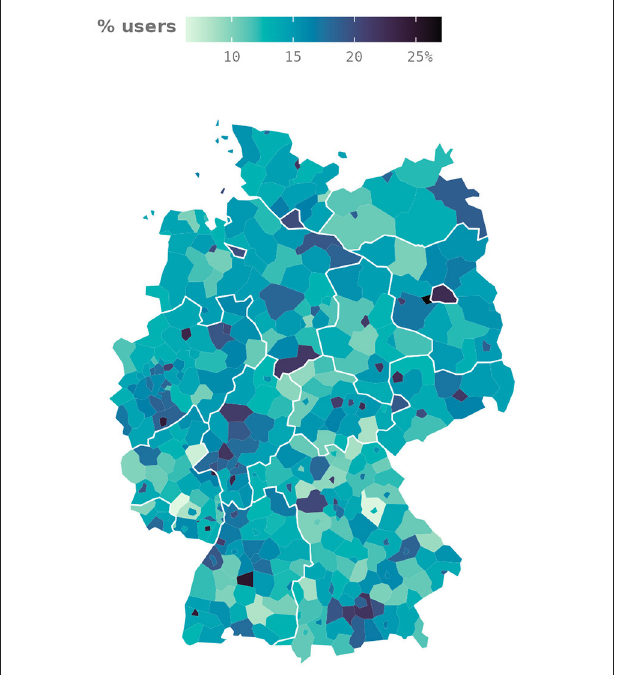
FIGURE 6 | Percentage of Twitter users who used gender-inclusive language at least once by NUTS-3 region.